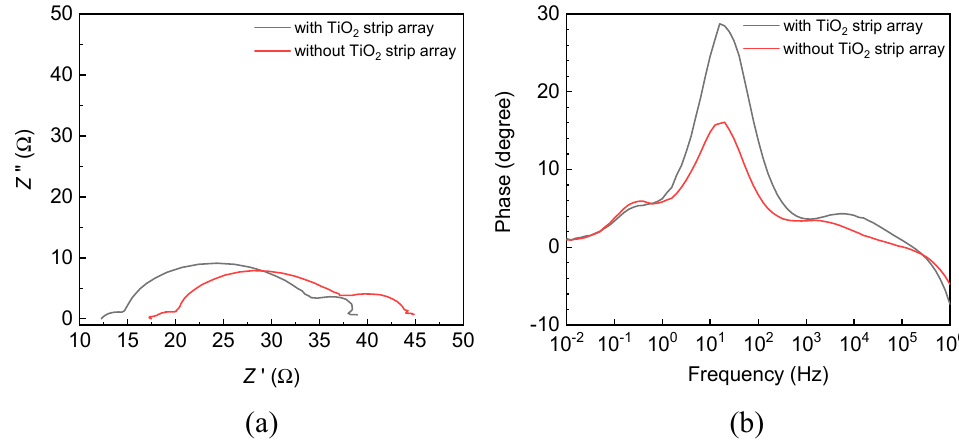
Figure 7. ( a ) Nyquist and ( b ) Bode plots of DSSCs with and without a TiO 2 strip array. Table 2 displays the averaged series resistances ( R s , R ct , and R ec ), averaged peak frequencies ( f p ) of the Bode plots, and averaged electron lifetimes ( τ ) for the DSSCs with and without the TiO 2 strip array. R s is a series resistance related to the electron transport in the FTO/photoelectrode interface; R ct is a series resistance related to the electron transport in the electrolyte/Pt layer interface; and R rec is a series resistance related to the electron transport in the photoelectrode/electrolyte interface. f p is a peak frequency of the second semi-circle of a DSSC in its Bode plot. τ is given by τ = 1/(2 π × f p